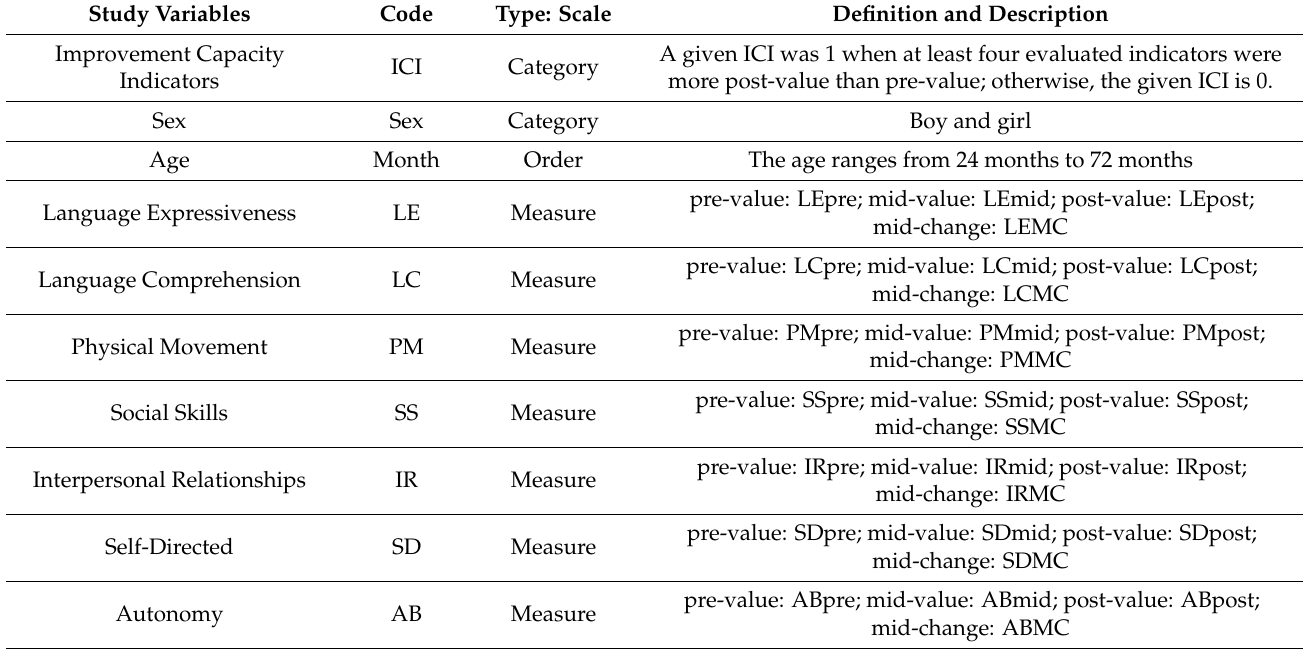
Table 1. The code, type, definition, and description of the study